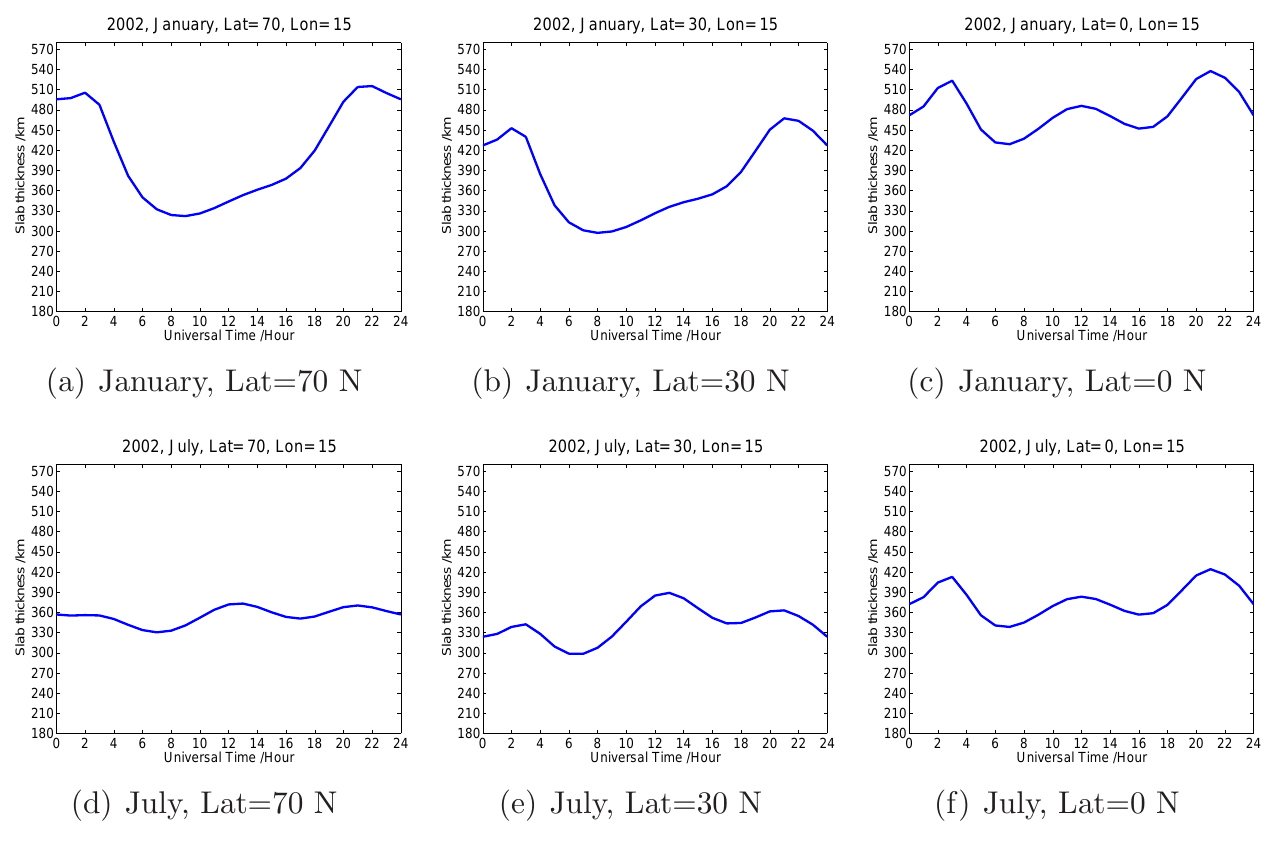
Figure 4: Variation of slab thickness,